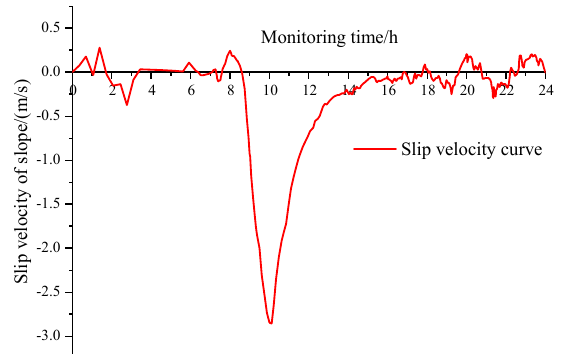
Figure 10. Speed curve of slope instability process.